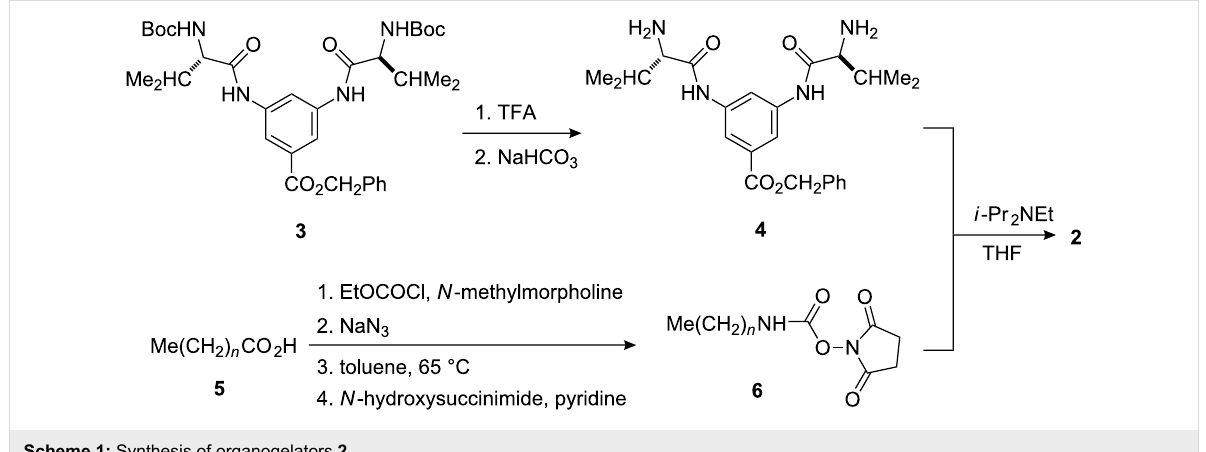
Scheme 1: Synthesis of organogelators 2